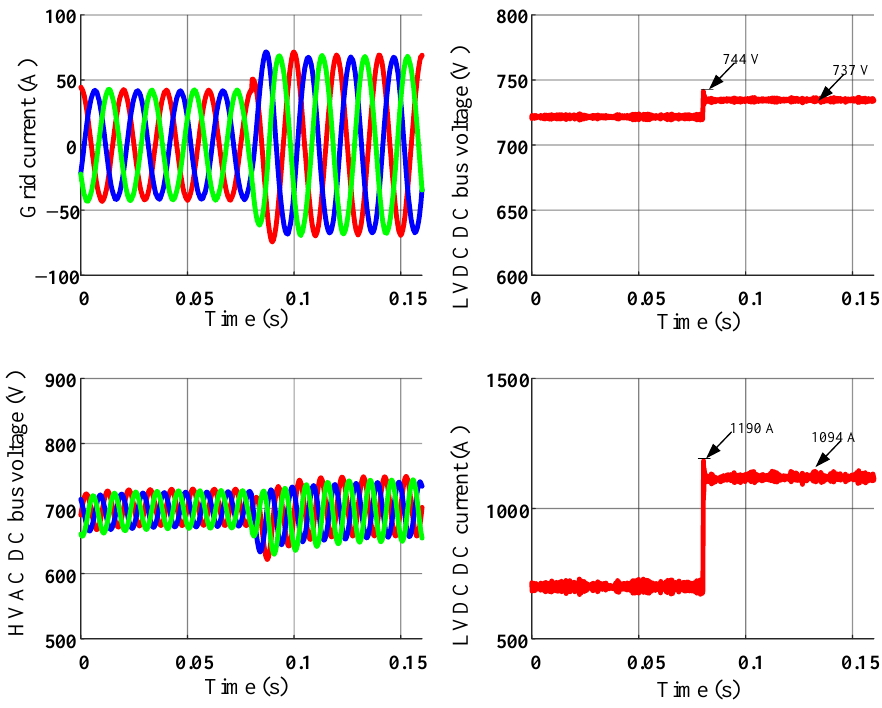
Figure 11. Simulation waveform (power from 50% step to 80% rated power).